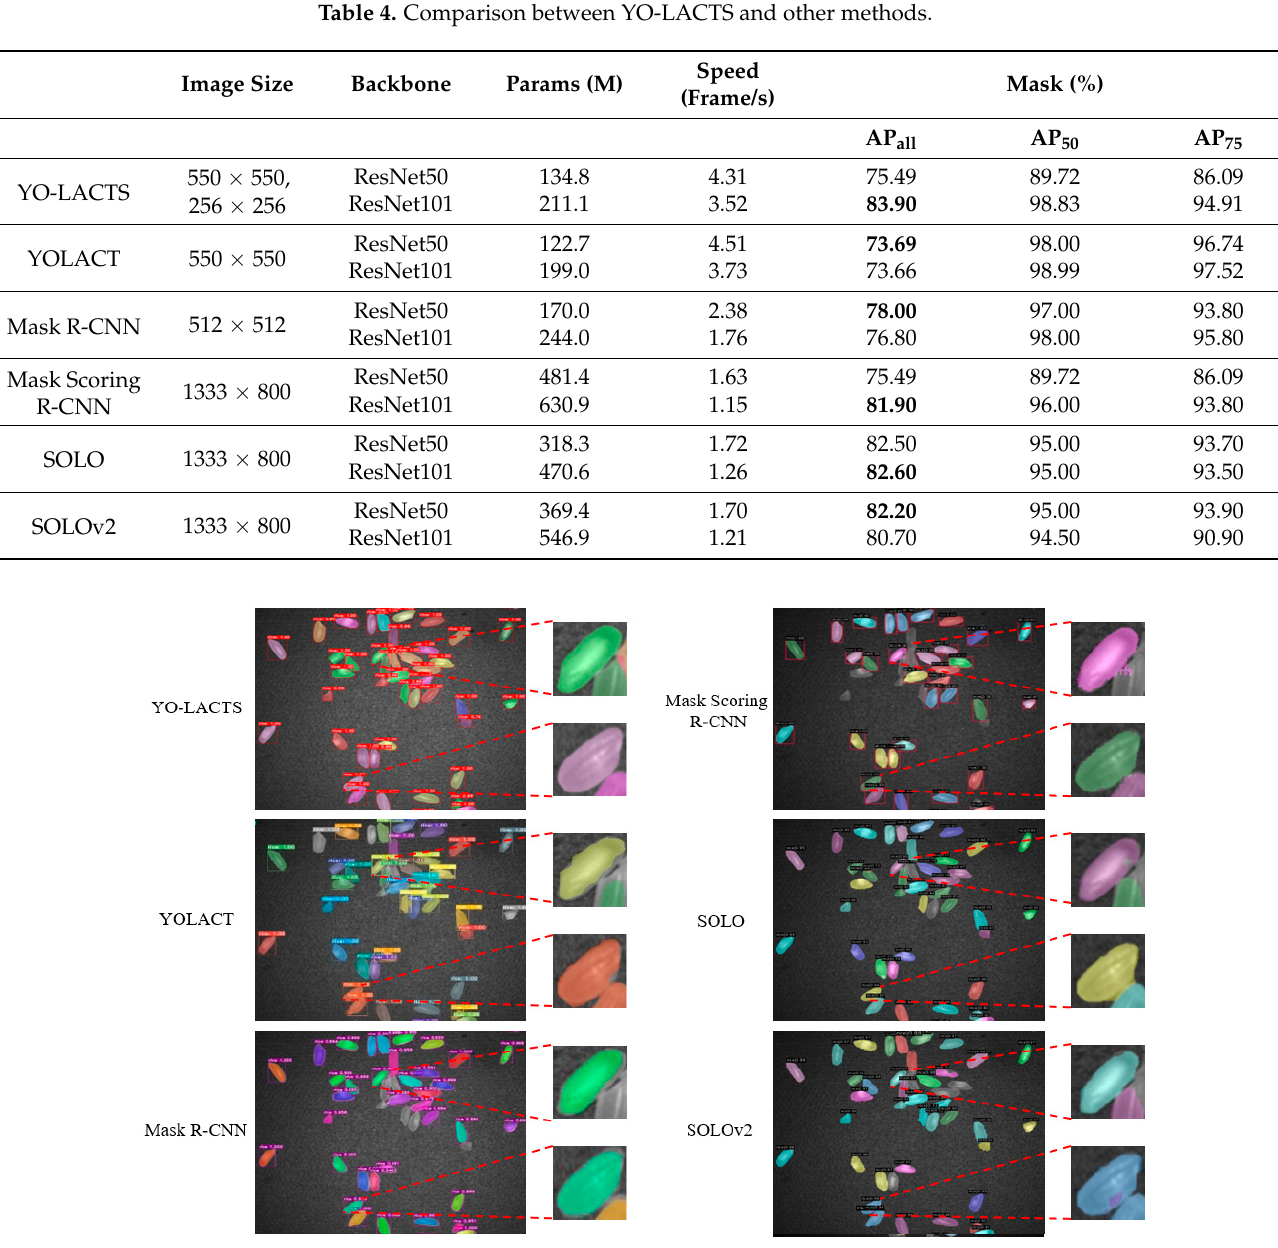
Figure 9. Comparison of YO-LACTS and other algorithms on polished rice image segmentation.